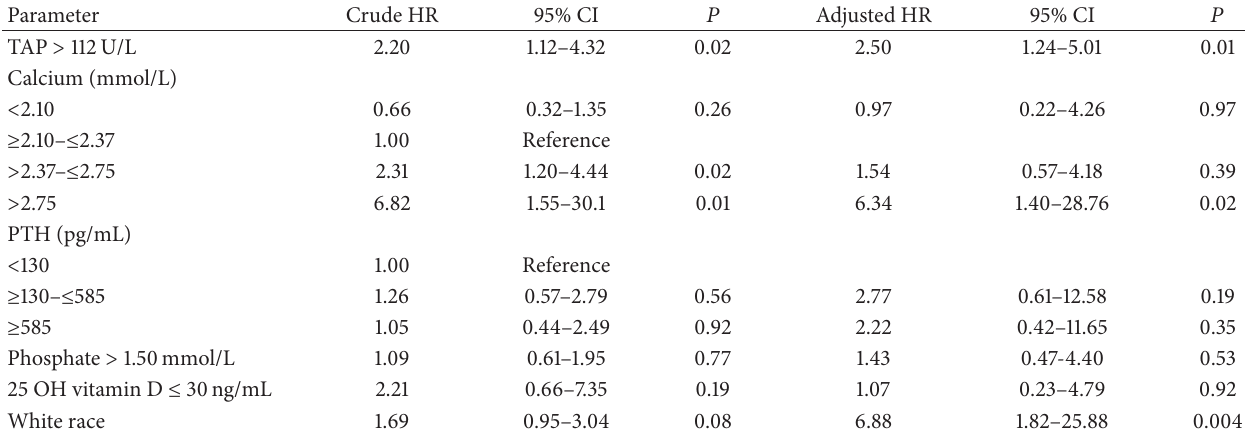
Table 4: Crude and adjusted hazard ratio (95% CI) of primary outcome by baseline characteristics.